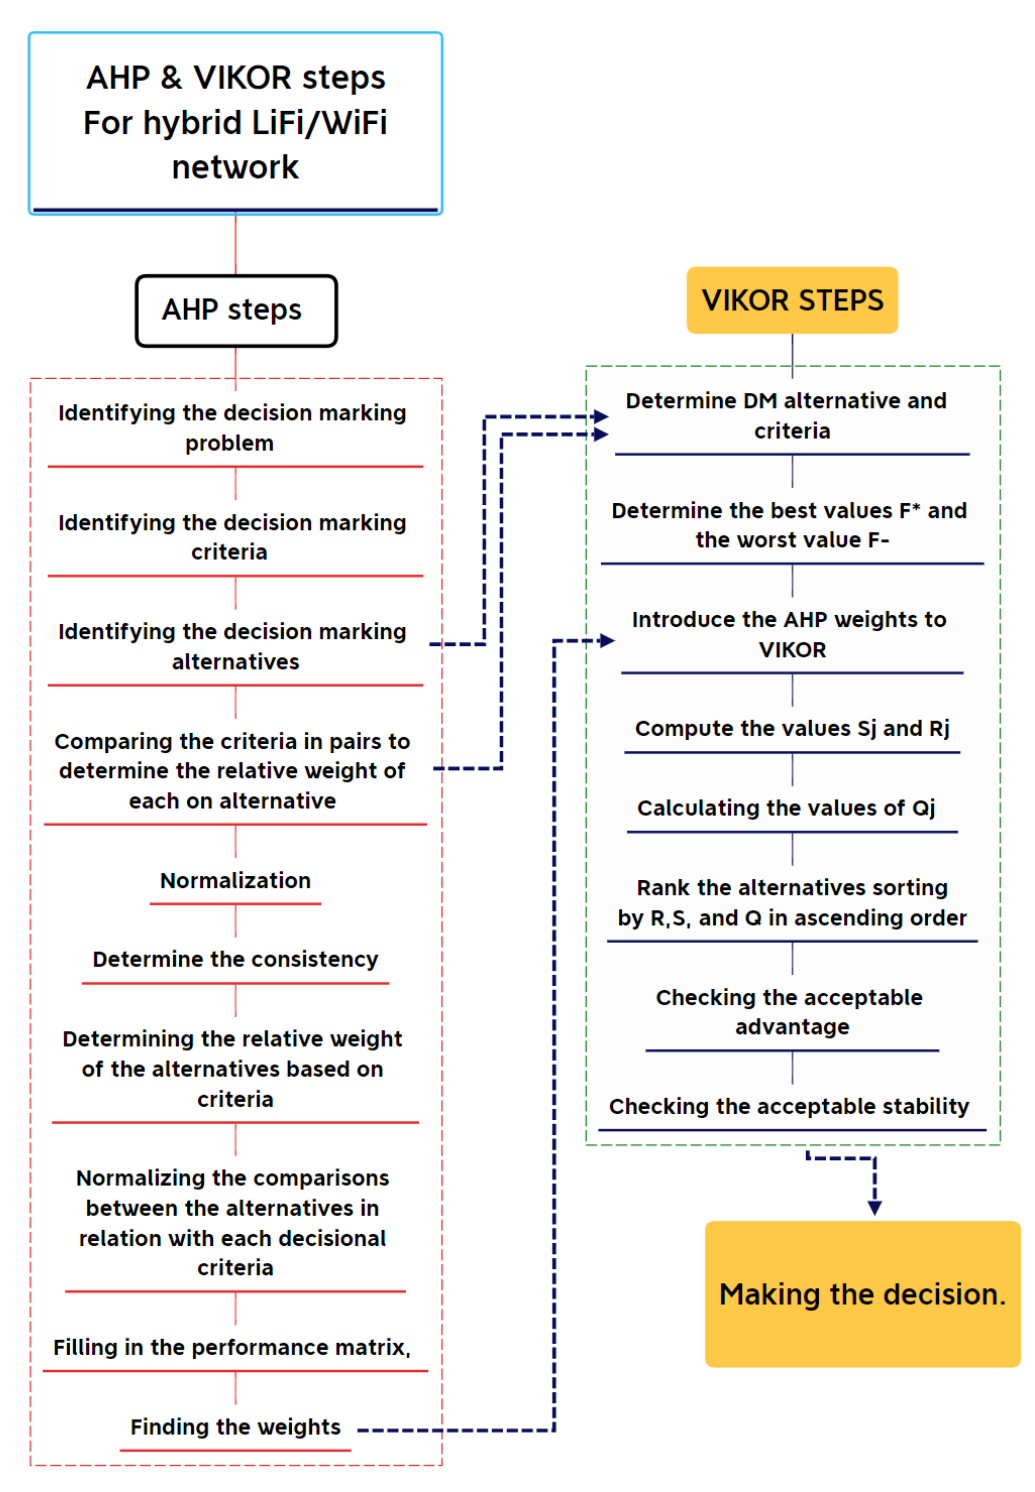
Figure 9. AHP – VIKOR integration steps. Figure 9. AHP–VIKOR integration